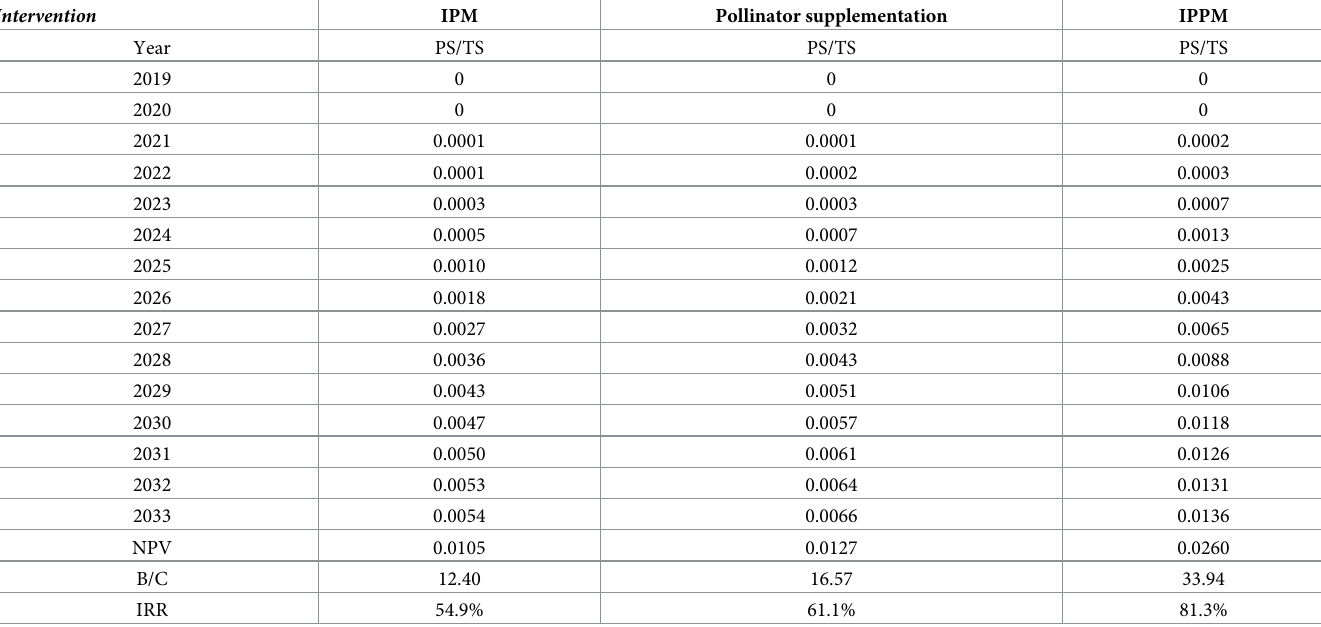
Table 3. Total economic benefits of adopting IPM, pollinator supplementation and IPPM in avocado production in Tanzania (‘Million US$). Intervention